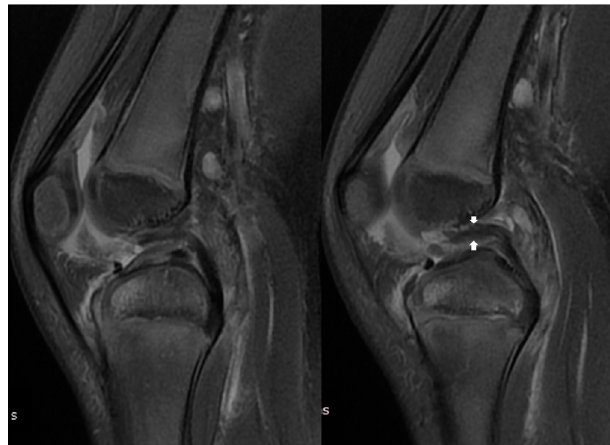
Figure 6. Case 2. First MRI with DP FS and sagittal sequences. Thickening of the proximal part of PCL (white arrows) with decreased PCL angle (right) and intact ACL